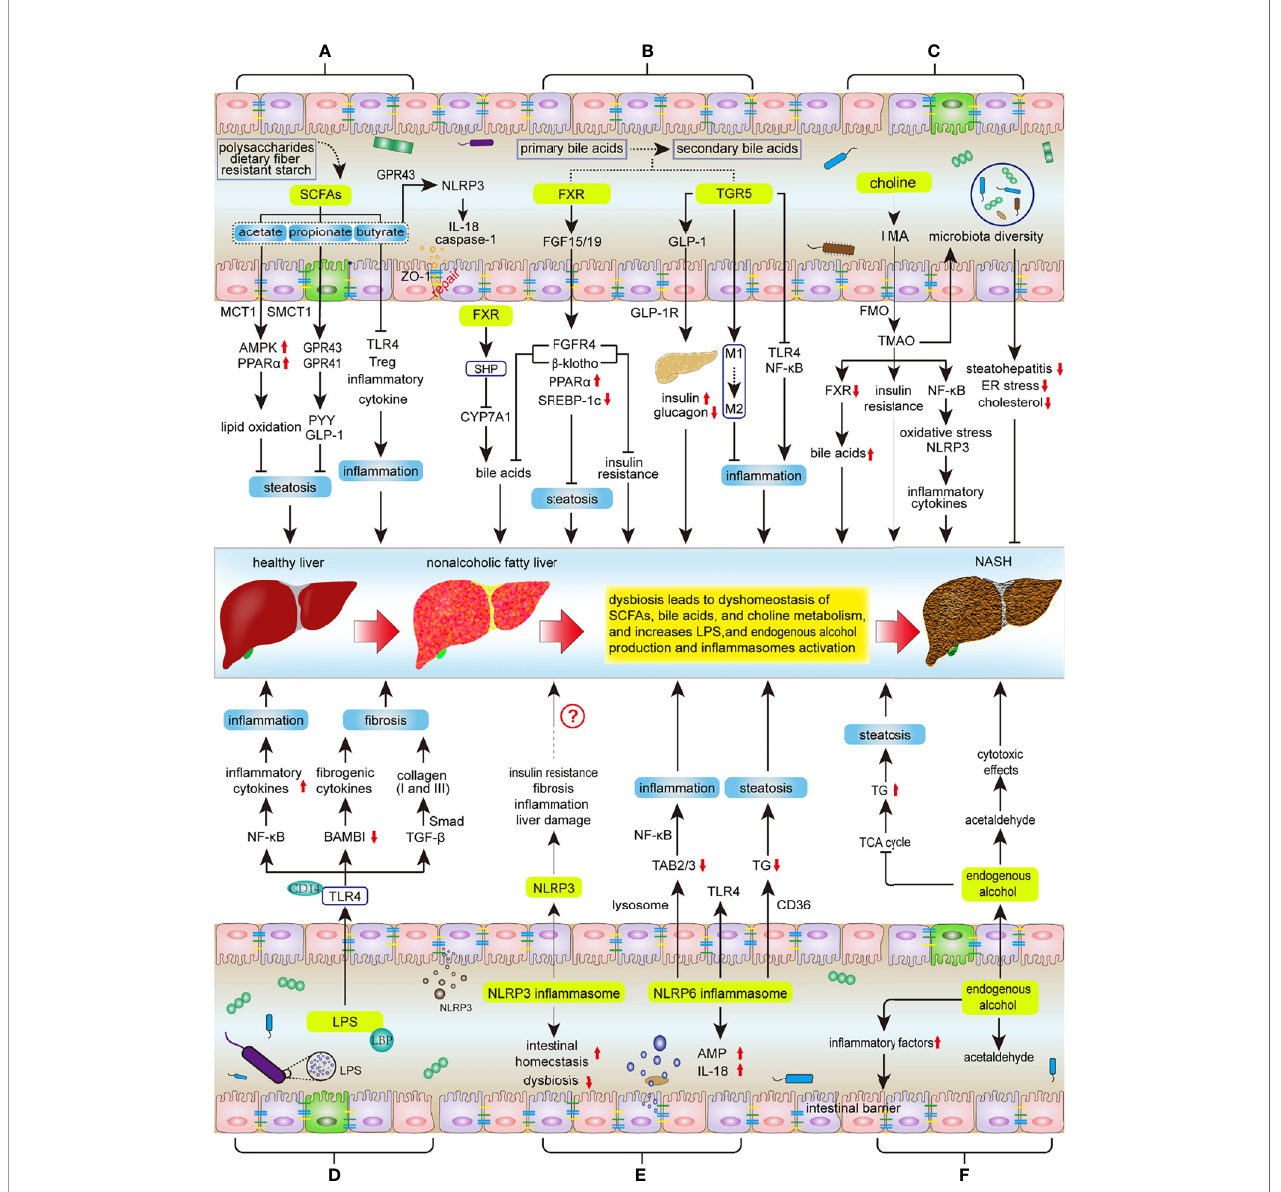
FIGURE 1 | Key mechanisms involved in the regulation of intestinal microbiota during NASH progression. Intestinal dysbiosis results in disruption of intestinal SCFAs, bile acids, and choline metabolic homeostasis, as well as increases LPS and endogenous alcohol production and NLPR3/6 activation, subsequently affecting the progression of ANSH: (A) SCFAs inhibit hepatic steatosis, in fl ammation, and protect the integrity of the intestinal barrier. Dysbiosis decreases SCFA production, thereby promoting the NASH process. (B) The metabolism of bile acids is regulated by FXR and TGR5. FXR signaling suppresses hepatic steatosis and insulin resistance, as well as negative feedback inhibits bile acid synthesis; TGR5 can protect the liver from in fl ammation and insulin resistance. However, dysbiosis will reduce the activity of FXR and TGR5 signaling. (C) Intestinal microbiota metabolizes choline to TMAO, but the effect of TMAO on NASH is controversial. (D) LPS mainly affects the progress of NASH through LPS-TLR4 and NF- k B signaling pathways, including hepatic in fl ammation, fi brosis and liver injury. (E) Activation of NLRP3 in the liver promotes liver damage, but NLRP3 in the intestine maintains intestinal homeostasis and improves intestinal dysbiosis. NLRP6 inhibits NASH progression by inhibiting TLR4/NF- k B signaling and TG accumulation and promoting AMP and IL-18 secretion. (F) Intestinal microbiota increases the production of endogenous alcohol and promotes the progress of NASH. SCFAs, short chain fatty acids; MCT1, monocarboxylate transporter 1; SMCT1, sodium ‐ coupled monocarboxylate transporter 1; AMPK, AMP activated protein kinase; PPAR a , Peroxisome proliferator-activated receptor a ; GPR41/43, G protein-coupled receptor 41/43; IL-18, Interleukin 18; PYY, peptide YY; GLP1, Glucagon like peptide 1; TLR4, Toll-like Receptor 4; Treg, regulatory T; FXR, Farnesol X receptor; LRH-1, liver receptor homolog 1; CYP7A1, cholesterol 7a hydroxylated enzyme; FGF15/19, fi broblast growth factors 15/19; FGFR4, fi broblast growth factor receptor 4; SREBP-1c, sterol regulatory element-binding protein 1c; TGR5, Takeda G protein-coupled receptor 5; GLP-1R, GLP-1 receptor; NF- k B, nuclear factor-kappaB, TMA, trimethylamine; TMAO, trimethylamine-N-oxide; FMO, fl avin monooxygenases; LPS, lipopolysaccharide; LBP, LPS binding protein; TGF- b , transforming growth factor- b ; BAMBI, bone morphogenetic protein and active membrane-bound inhibitor; AMPs, antimicrobial peptides; NLRP3/6, nucleotide-binding domain, leucine-rich-repeat containing family, pyrin domain-containing 3/6; TAB2/3, TGF- b activated kinase 1 binding protein 2/3; TG, triglyceride; TCA, tricarboxylic